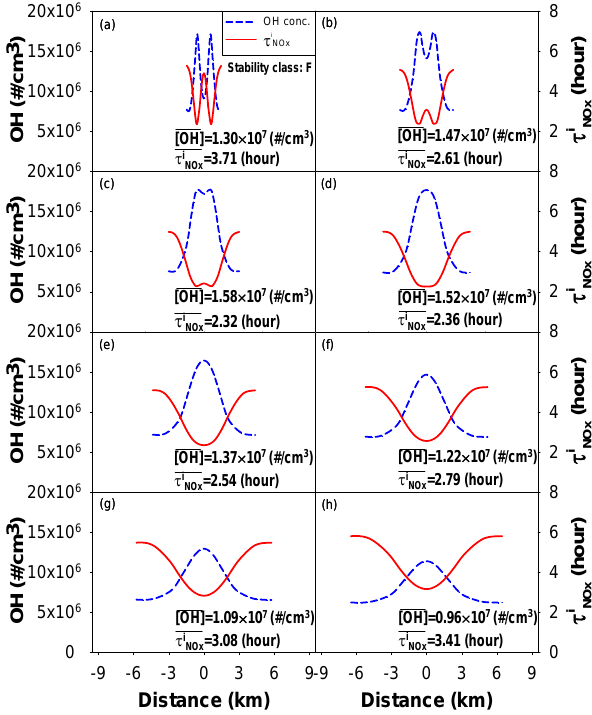
Fig. 11. OH radical concentrations and NO x lifetimes across the ship-plume transects A–H. (cid:2) OH (cid:3) and eraged OH concentration and instantaneous NO x lifetime over the ship-plume transects A–H, respectively. UBoM 2K8 models were run at the stability condition of stable (F). The panels (a–h) corre- spond to the results at the ship-plume transects A–H, sequentially.